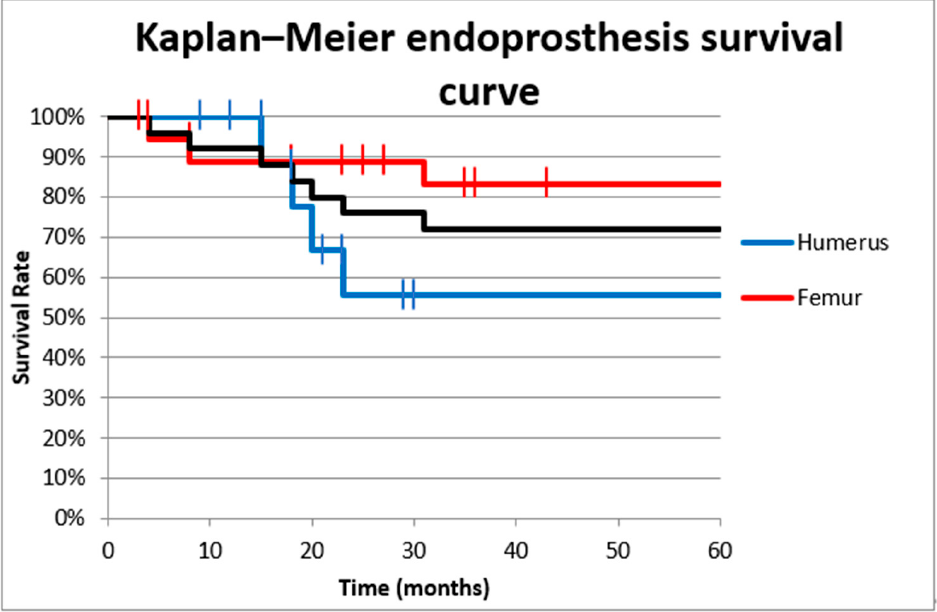
Figure 2. Cumulative survival curve of intercalary endoprostheses for metastases in the femoral and humeral diaphysis. The overall survival 1 year after surgery was 92% (88.8% in the femur and 100% in the humerus). The 5-year overall survival rate was 72% (83.3% in the femur and 55.5% in the humerus).